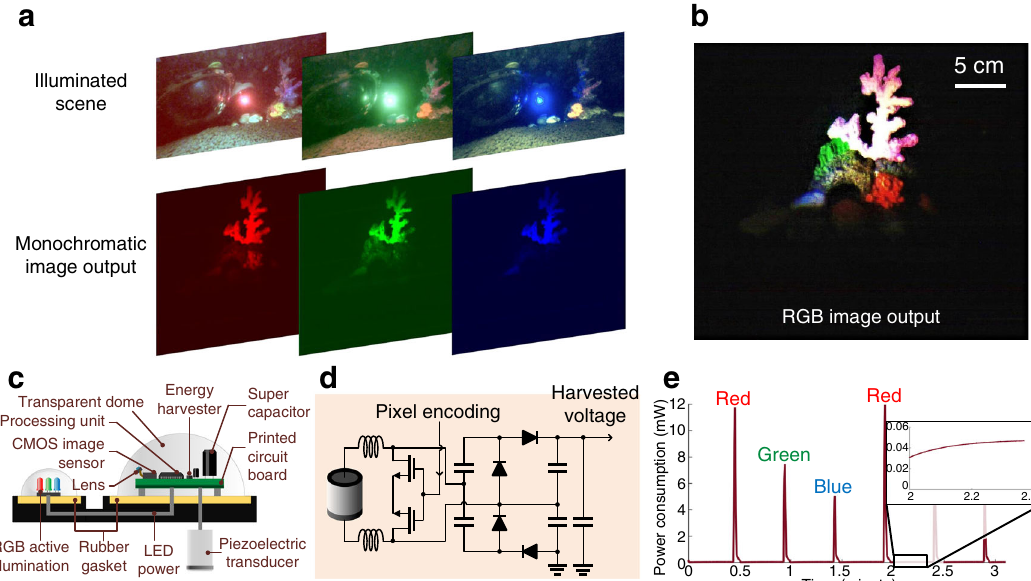
Fig. 2 | Active illumination in underwater backscatter imaging. a To recover color images with a monochrome sensor, the camera alternates between acti- vating three LEDs — red, green, and blue. The top fi gures show the illuminated scene, while the bottom fi gures show the corresponding captured monochro- matic images, which are transmitted to a remote receiver. b The fi gure shows the color image output synthesized by the receiver using multi-illumination pixels which are constructed by combining the monochromatic image output for each of the three active illumination LEDs. c A side view of the camera